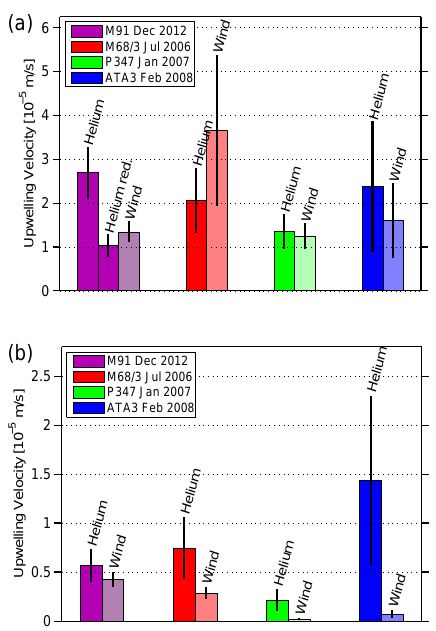
Figure 4. Mean values of helium- and wind-derived upwelling ve- locities for the coastal (a) and offshore (b) areas of cruises M91, M68/3, P347 and ATA3. The vertical black line indicates the stan- dard deviation of the mean. “Helium red” in (a) means that the helium-derived upwelling is calculated with reduced gas exchange velocity due to the presence of surface organic films, for details see